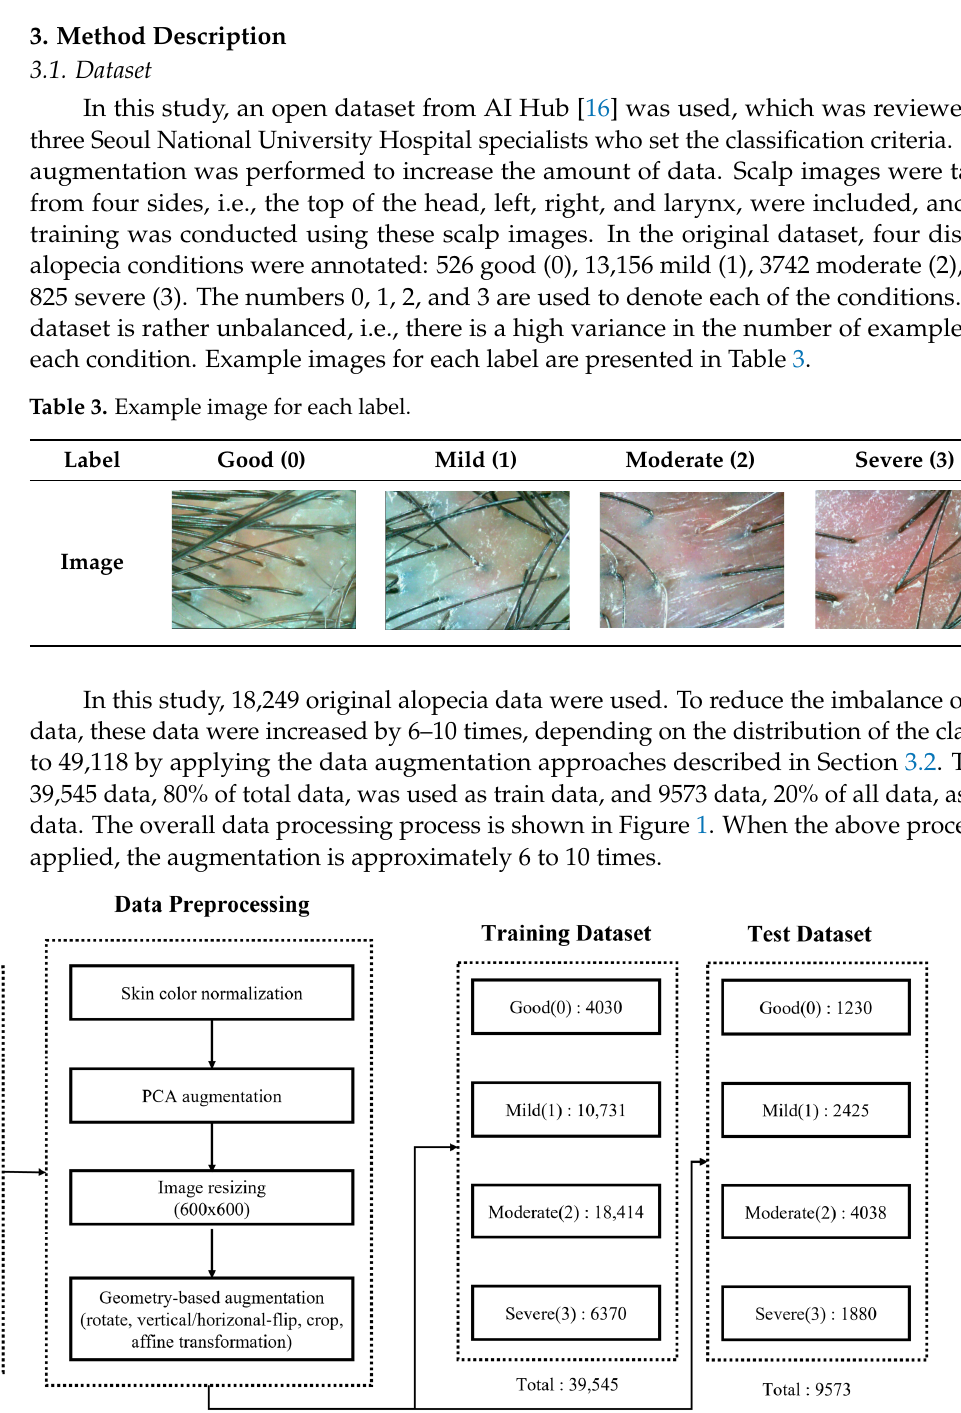
Figure 1. Data preprocessing and data augmentation of scalp images.